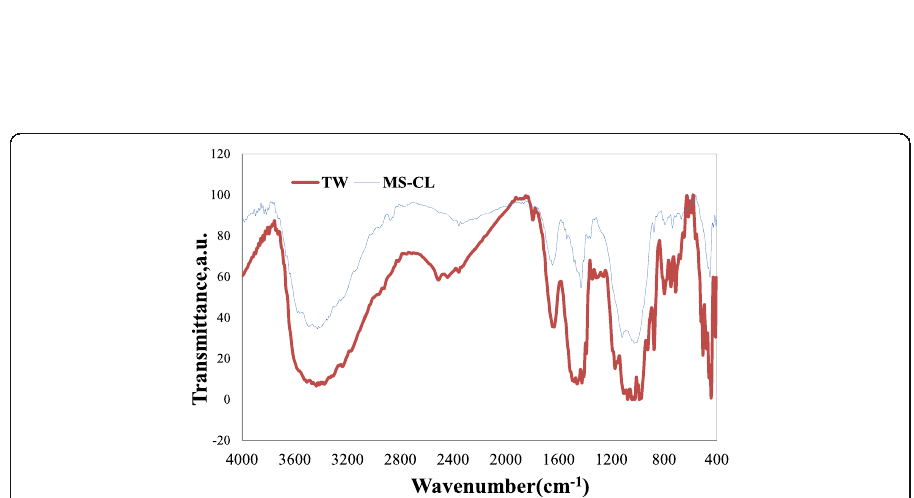
Fig. 15 I.R. spectra of GPCC100 samples under ACS with different aggressive